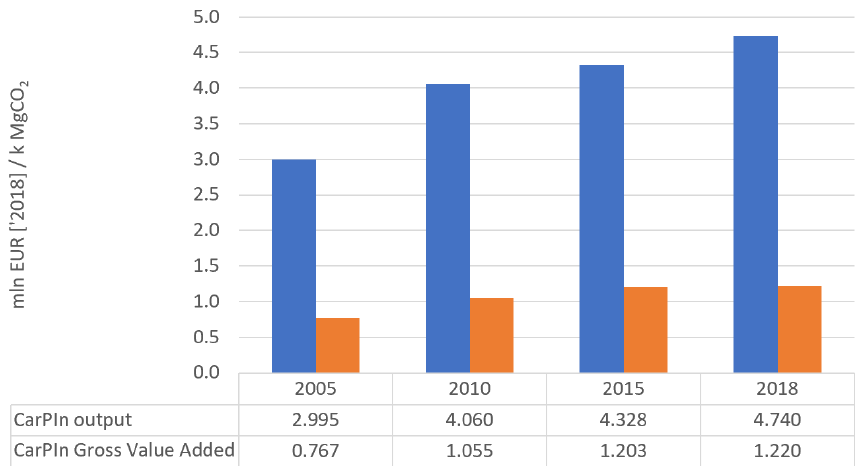
Figure 7. Carbon Productivity Indexes in Poland (Manufacturing overall) (million EUR/k Mg CO 2 ) in 2005 – 2018 (own study).